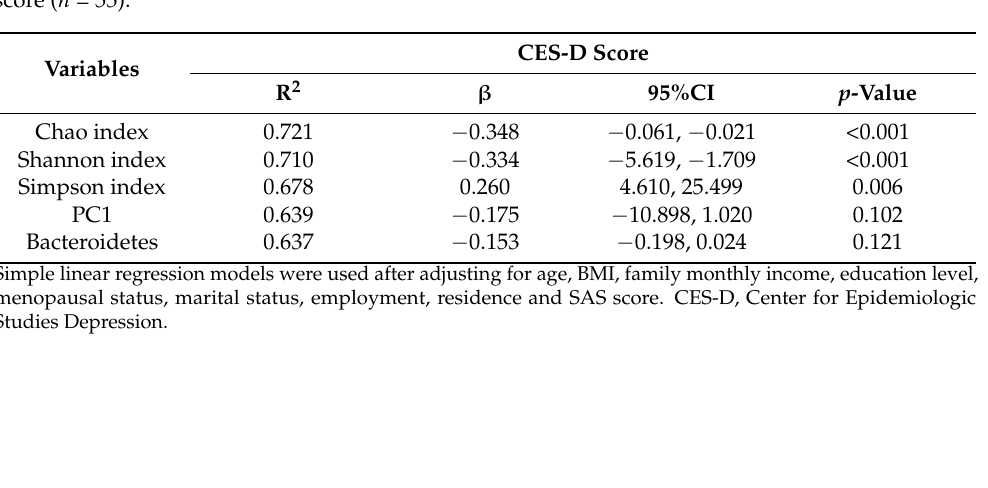
Table 3. Linear regression analyses of the associations between the gut microbiota and the CES-D score ( n =